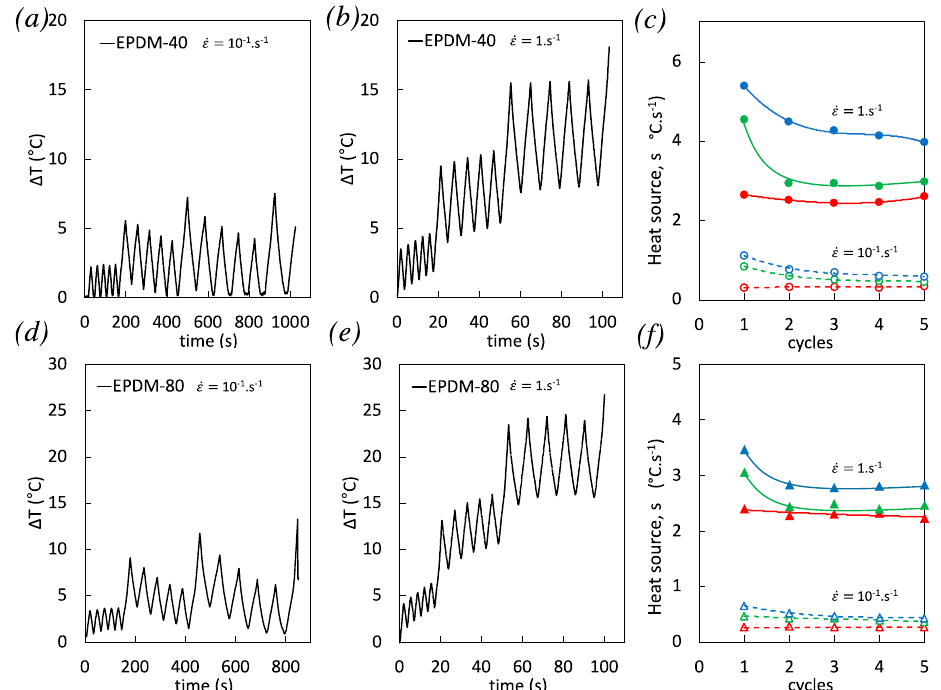
Figure 7. ( a – b ) Self-heating at the strain rates 10 − 1 s − 1 and 1 s − 1 for EPDM-40. ( c ) Corresponding temperature rise measured between the minimum and maximum strain reached during the loading phase of the cyclic loadings performed at three di ff erent stretching ratios λ 1 = 2 (in red), λ 2 = 2.9 (in green), and λ 3 = 3.7 (in blue), and for the strain rates 10 − 1 s − 1 (unfilled symbols) and 1 s − 1 (filled symbols). ( d – e ) Self-heating at the strain rates 10 − 1 s − 1 and 1 s − 1 for EPDM-80. ( f ) Corresponding temperature rise measured between the minimum and maximum strain reached during the loading phase of the cyclic loadings performed at three di ff erent stretching ratios λ 1 = 2 (in red), λ 2 = 2.9 (in green), and λ 3 = 3.9 (in blue), and for the strain rates 10 − 1 s − 1 (unfilled symbols) and 1 s − 1 (filled symbols).